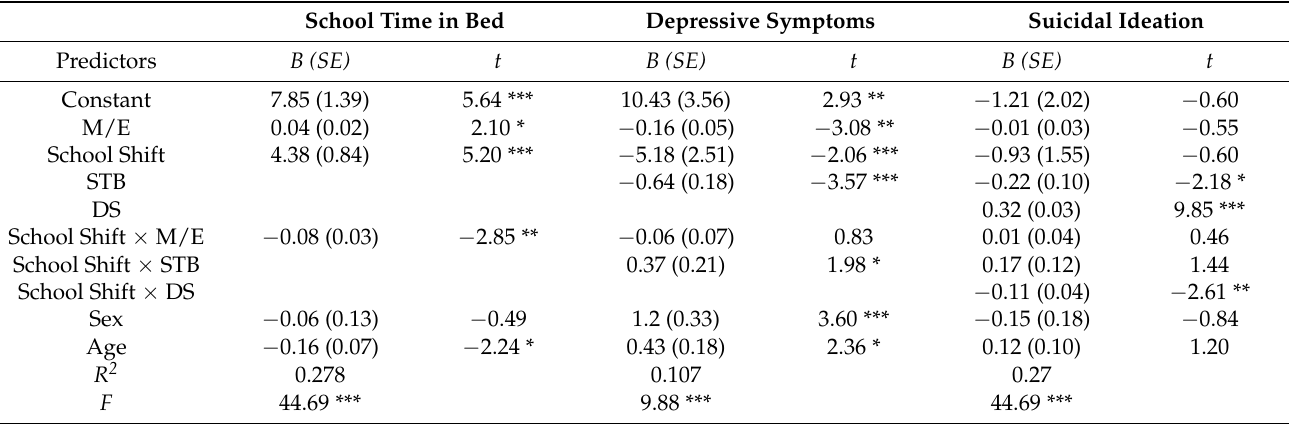
Table 5. Morningness/eveningness (M/E) effect on suicidal ideation through school time in bed (STB) and depressive symptom (DS) mediators, with school shift as the moderator and sex and age as covariables.